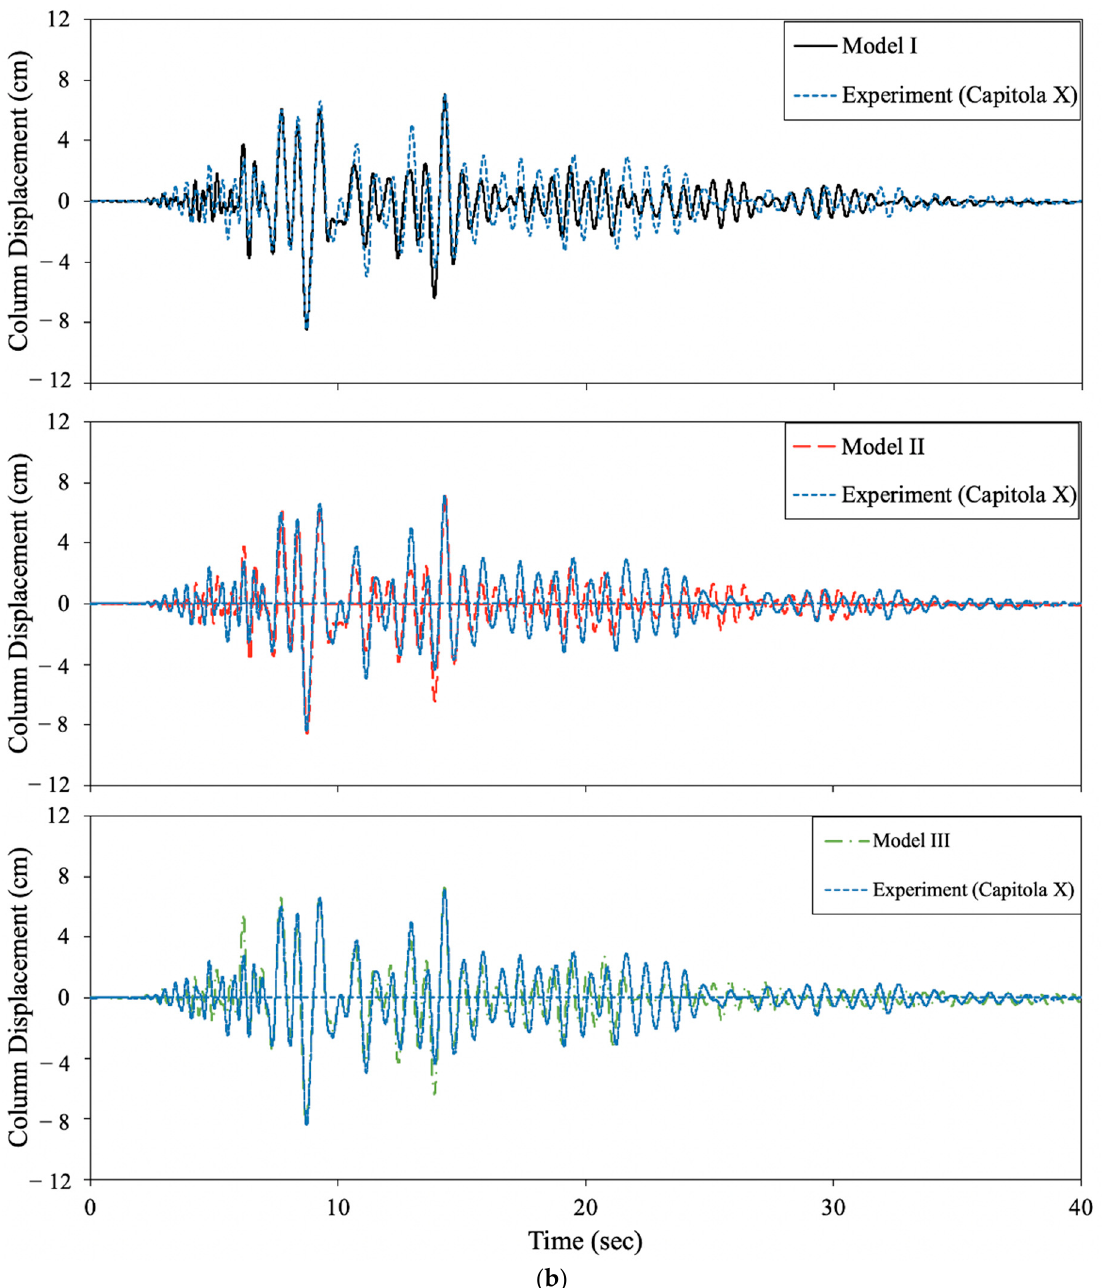
Figure 16. Column displacement histories comparison: ( a ) Curico X record; ( b ) Capitola X record.